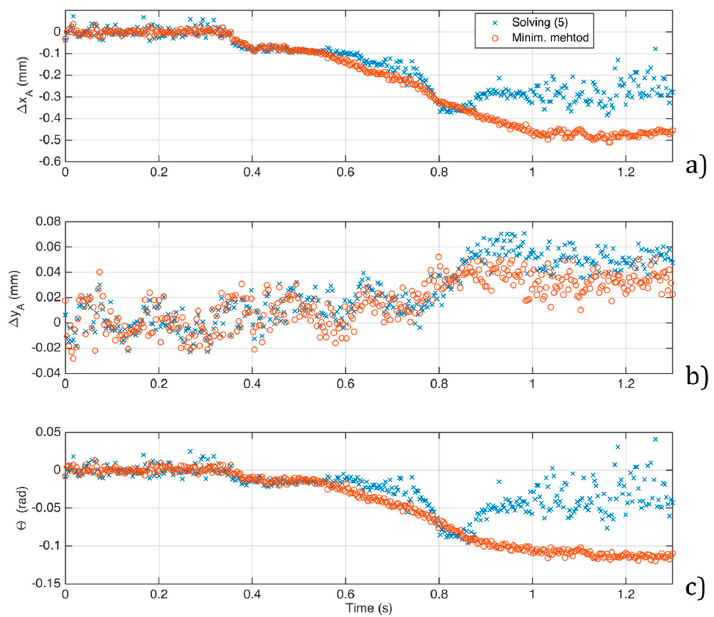
Figure 10. ( a ) x -displacements at A, ( b ) y -displacements at A, and ( c ) torsional angle computed using the proposed minimization method (red) and separately solving Equation (5) (blue).